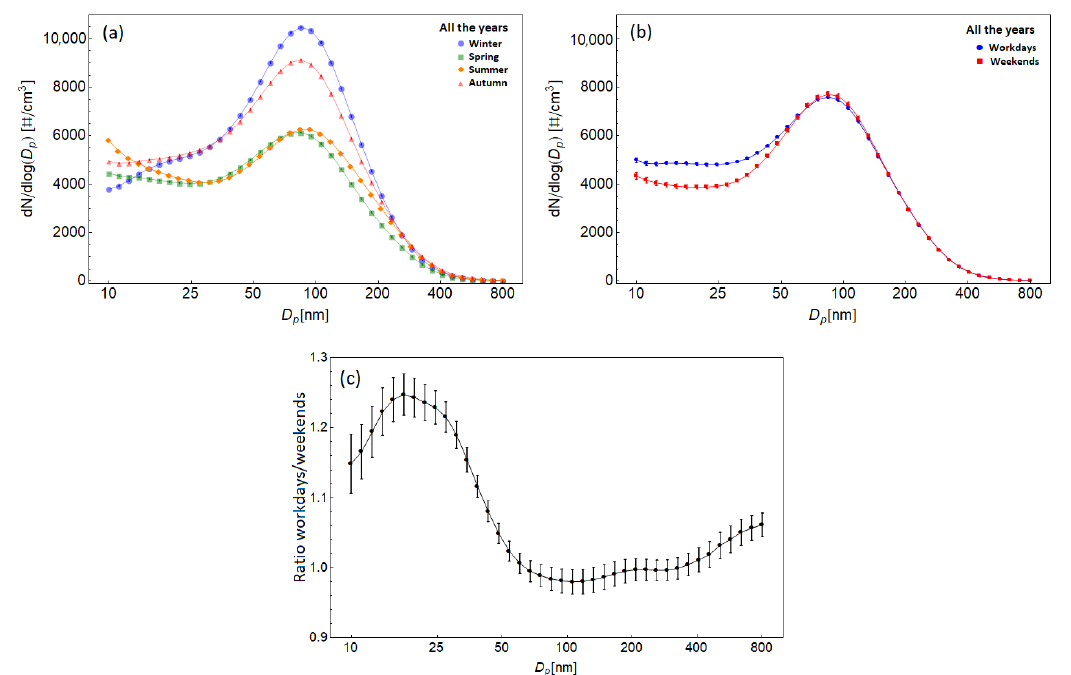
Figure 3. Particle number size distributions average over all years during different seasons ( a ), during workdays and weekends ( b ), and workdays/weekends ratio ( c ). Vertical bars represent the standard errors that are comparable with the size of symbols in part ( a ) and ( b ).